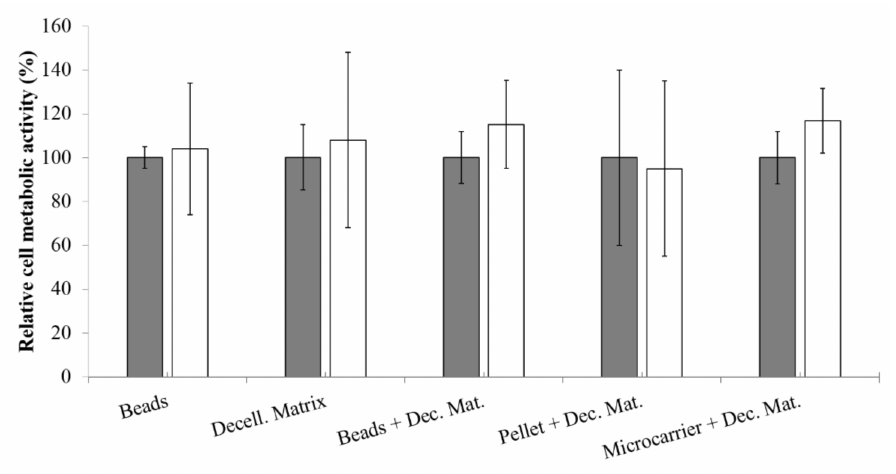
Figure 4. Relative cell metabolic activity (percentage) of chondrocytes for each 3D model before (grey bars) and after (white bars) stimulus with pro-inflammatory cytokine IL-1 β (48 h). Mean values obtained from three cell lines ± standard deviations. Each condition was tested in triplicate (experimental sample size =